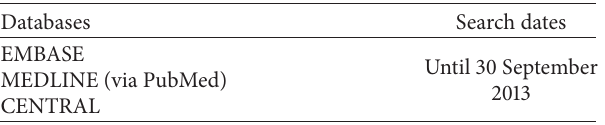
Table 1: List of databases and search periods included in systematic